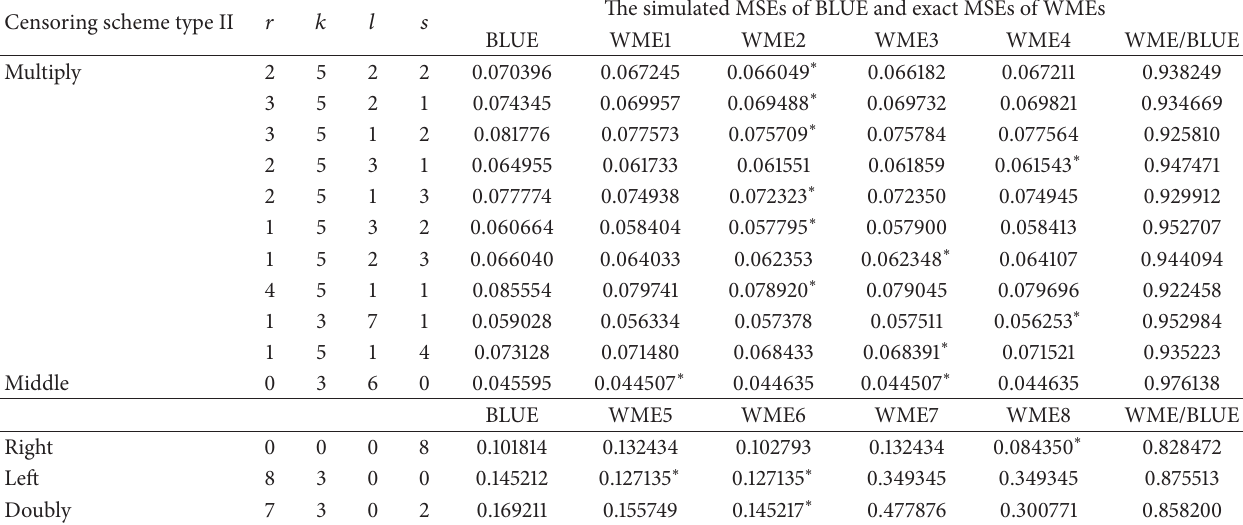
Table 1: MSEs of BLUE and WMEs of the scale parameter 𝜎 at 𝑁 = 15 , 𝜎 = 1.0 , and 𝜃 = 1 .